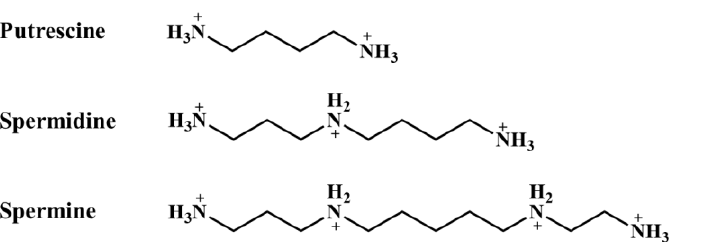
Figure 1. Cationic forms and structures of the three major polyamines in mammalian cells under physiological